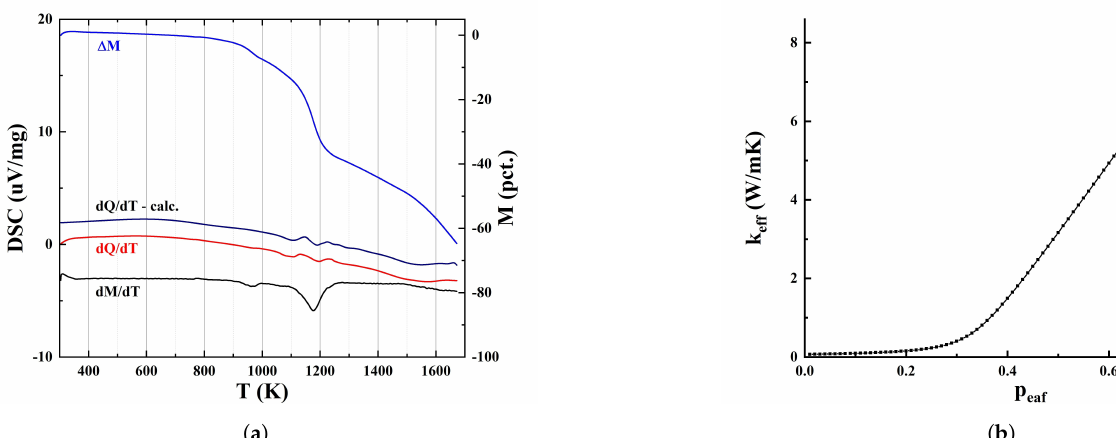
Figure 5. Differential scanning calorimetry of powder ( a ) and the dependency of the effective thermal conductivity on the volume fraction of EAF dust ( b